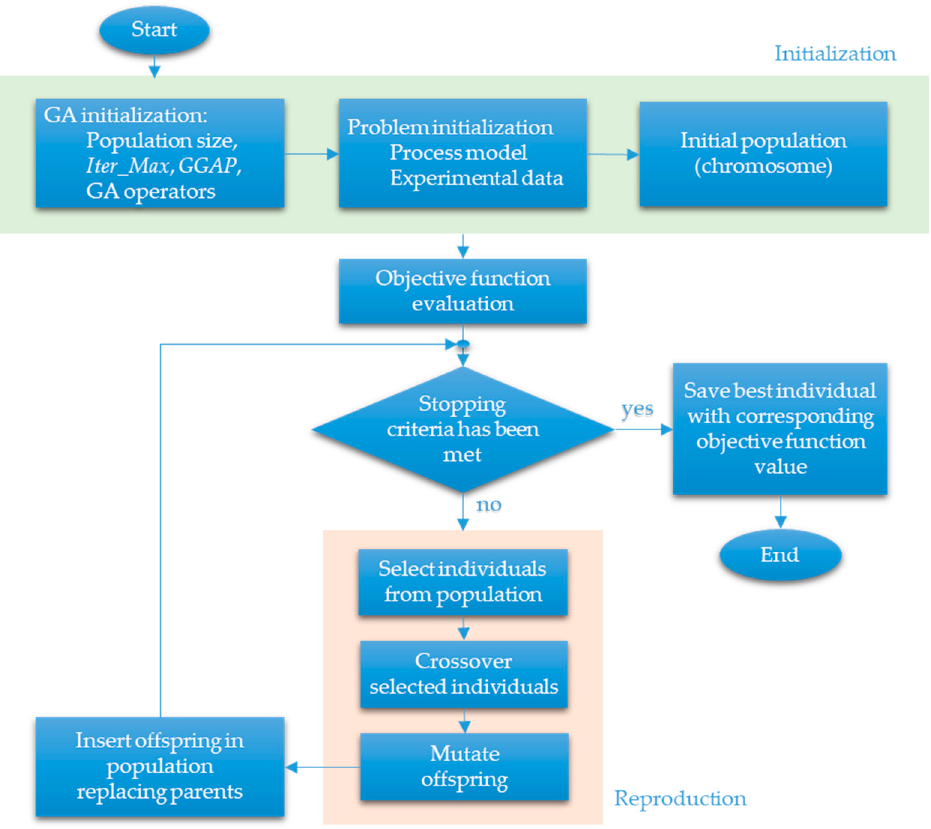
Figure 3. Block chart of genetic algorithm (GA).